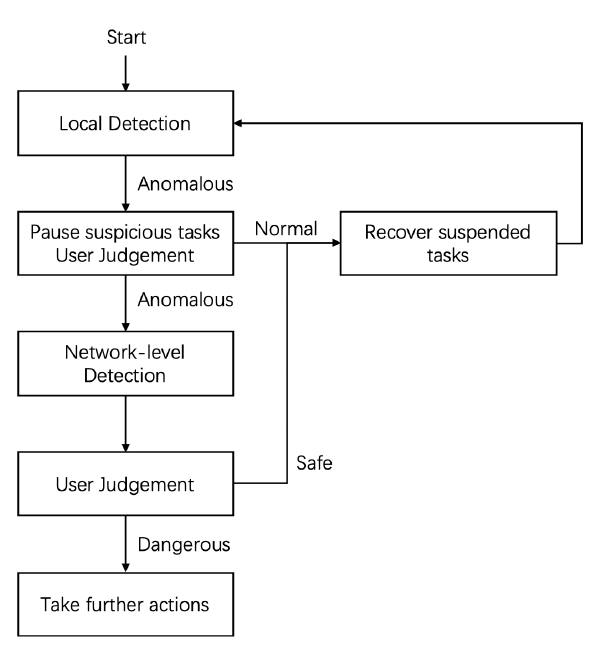
Figure 1. Workflow of